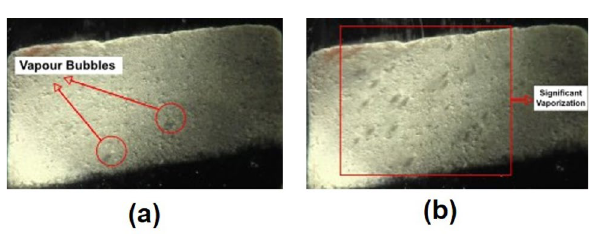
Figure 11. ( a ) Initiation of vapour-phase (nucleation) in Berea sandstone; ( b ) significant propane vaporization in Berea sandstone.